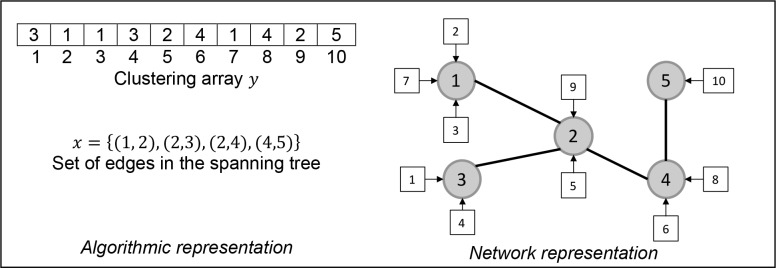
Solution coding.